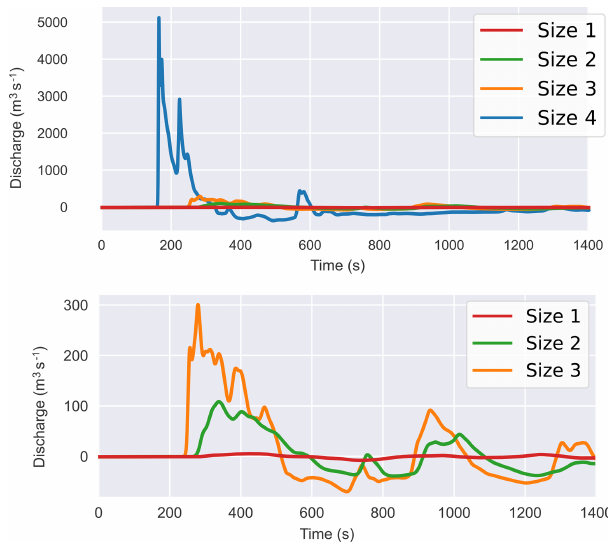
Figure 11. Discharge at Waikato River inlet measured across sec- tion A, as illustrated in Fig. 3, for the different size sources located at Taup¯o.